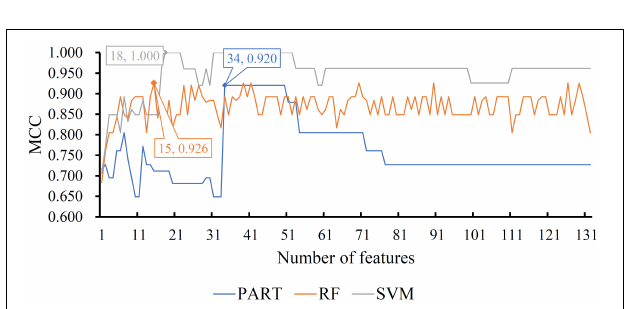
FIGURE 6 | IFS curves with different classification algorithms on different number of methylation features for HIPPO brain structure. The RF, SVM, and PART yield the highest MCC of 0.926, 1.000, and 0.920, respectively. They are obtained by using top 15, 18, and 34, respectively, features in the list.